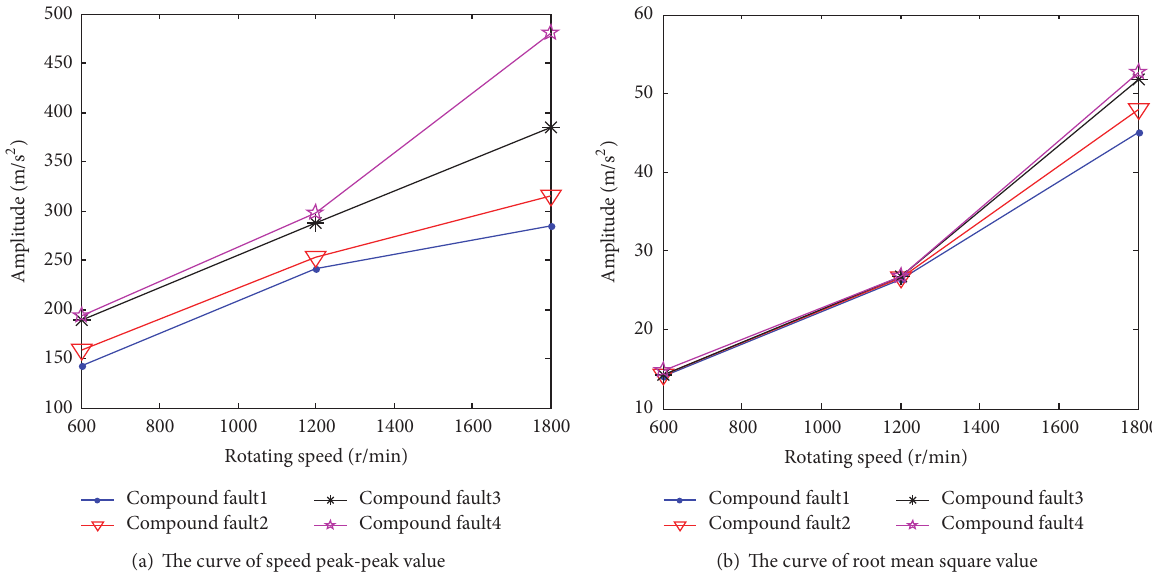
Figure 7: The curve of compound fault on load 1790 N ⋅ m.